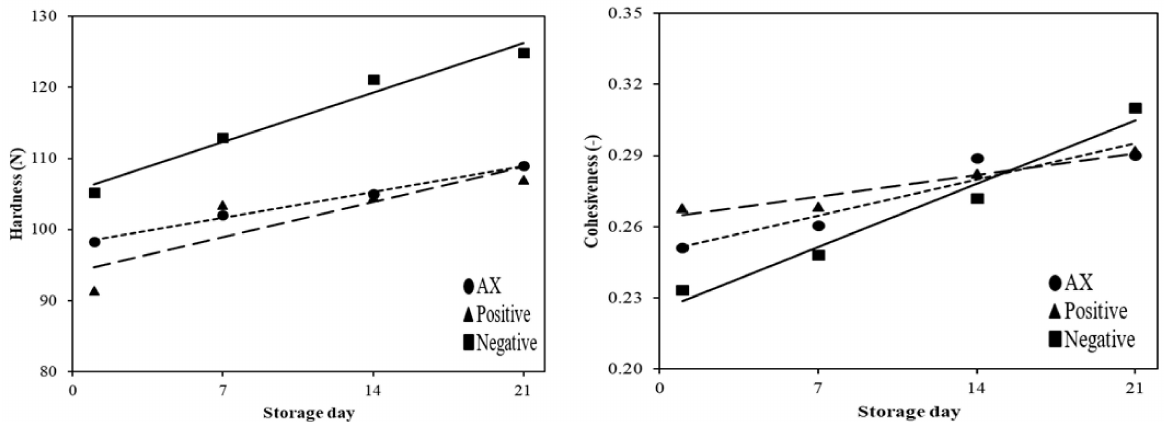
Figure 3. Effect of antioxidants on the textural properties of emulsified sausages. The solid lines are for the negative control, the large dashed lines for the positive control, and the small dashed lines for AX. Negative: without antioxidant; Positive: with 200 mg/kg mixture of BHT and BHA (1:1, w / w ); AX, with 400 mg/kg